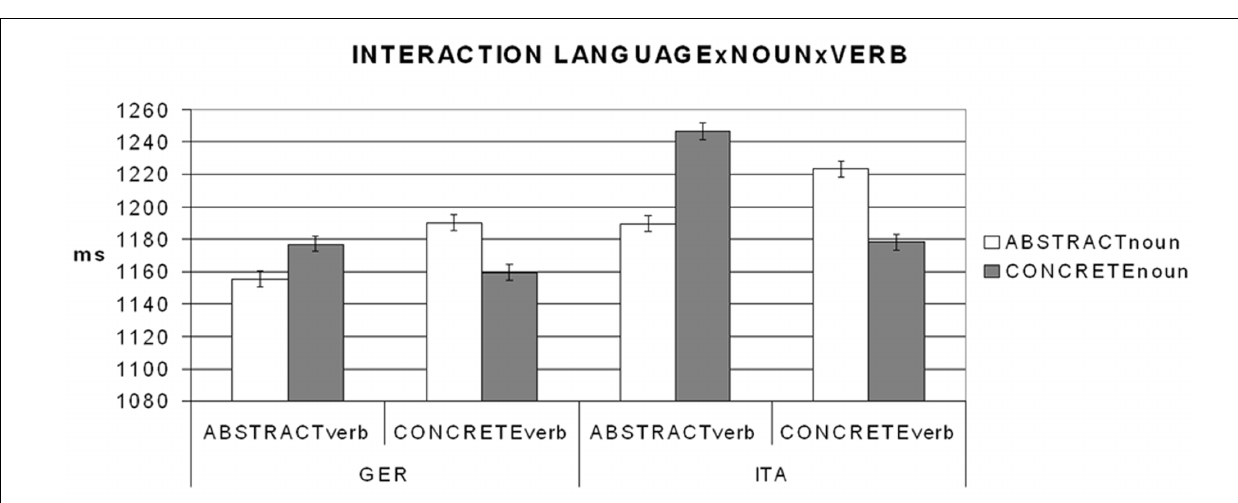
pairs and Concrete Verb – Abstract Noun pairs ( M = 10.45